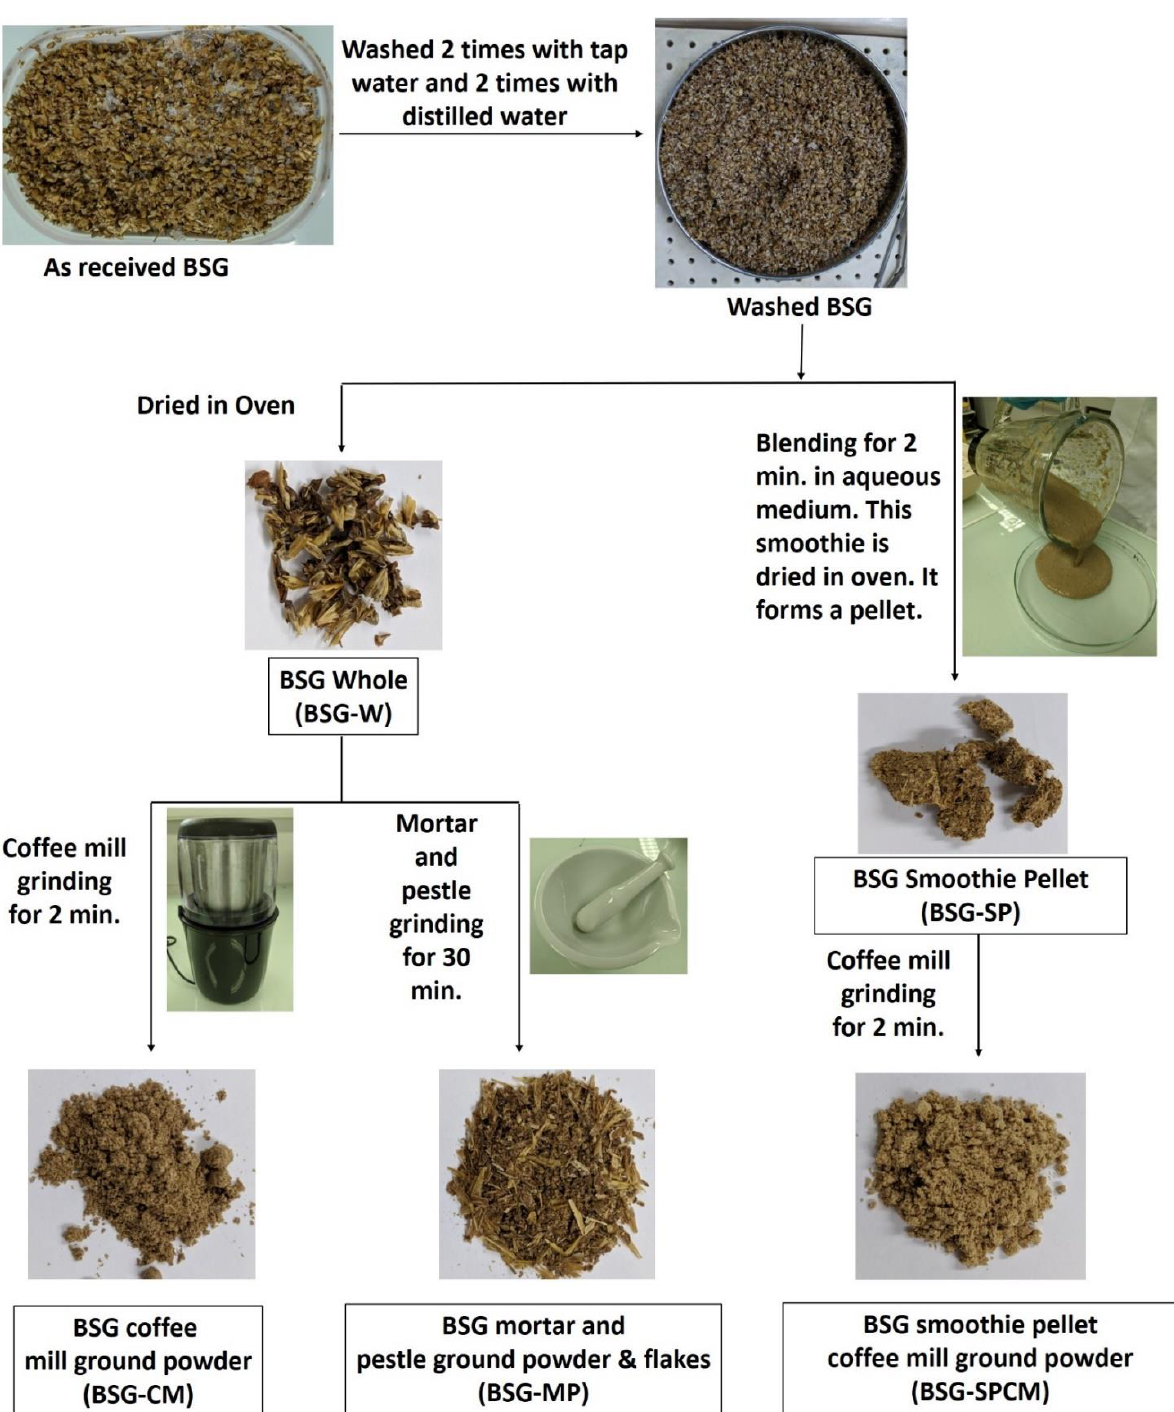
Figure 2. Schematic representation of the procedure to create different samples from the same biomass.